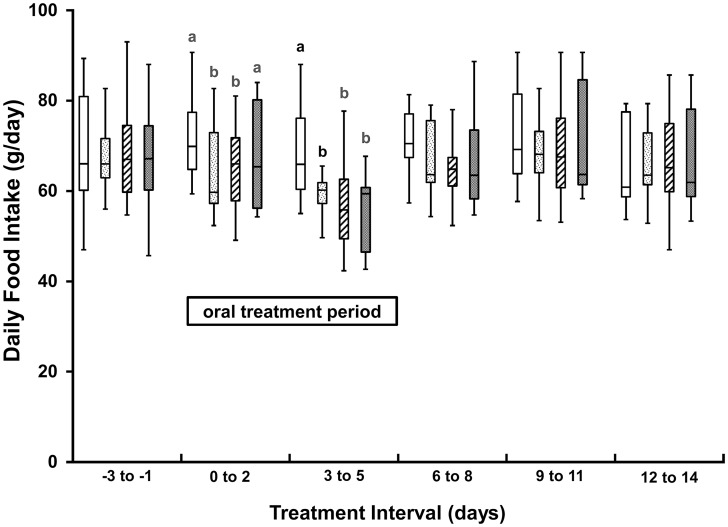
Box-whisker plots of daily food intake of 8 cats during 3-day periods preceding (days -3 to -1), during (days 0 to 5), and after (days 6 to 14) oral ingestion of vehicle (open boxes) and E2 at dosages of 0.5 (stippled boxes), 1.0 (diagonal line boxes), and 2.0 (shaded boxes) μg/kg body weight.Boxes represent the 25 to 75th percentile, central lines represent medians, and whiskers show the minimum and maximum observations on 6 cats. Food intake observations within 3-day periods are different (p≤0.05) where letters above plots are different.